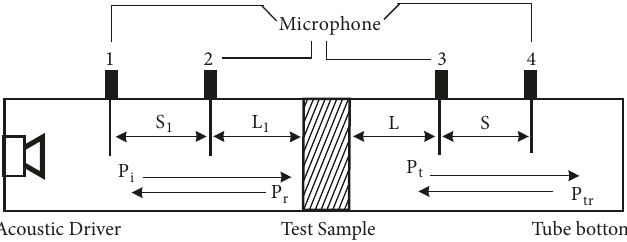
Figure 3: Impedance tube